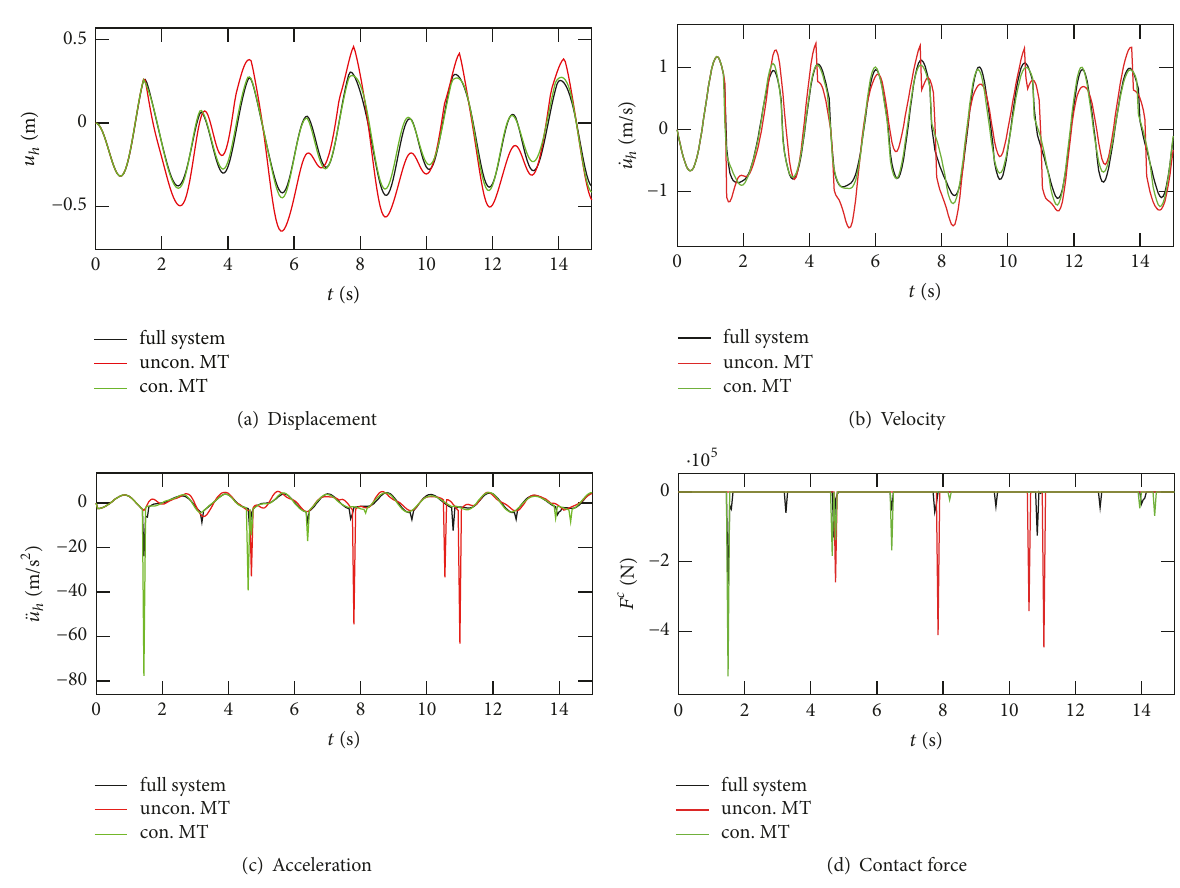
Figure 7: Results for the displacement, the velocity, and the acceleration as well as the contact force with 𝑚 = 10 .